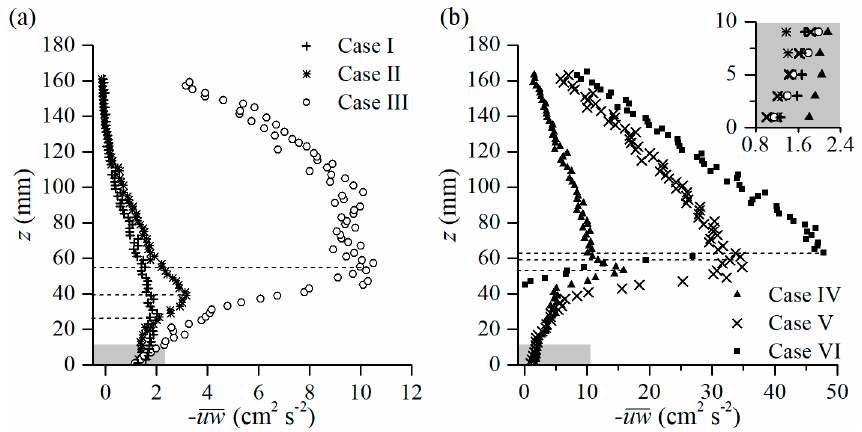
Figure 6. − uw profiles with di ff erent vegetation densities, ( a ) from Case I to Case III and ( b ) from Case Figure 6. uw − profiles with different vegetation densities, ( a ) from Case I to Case III and ( b ) from IV to Case Case IV to Case VI.